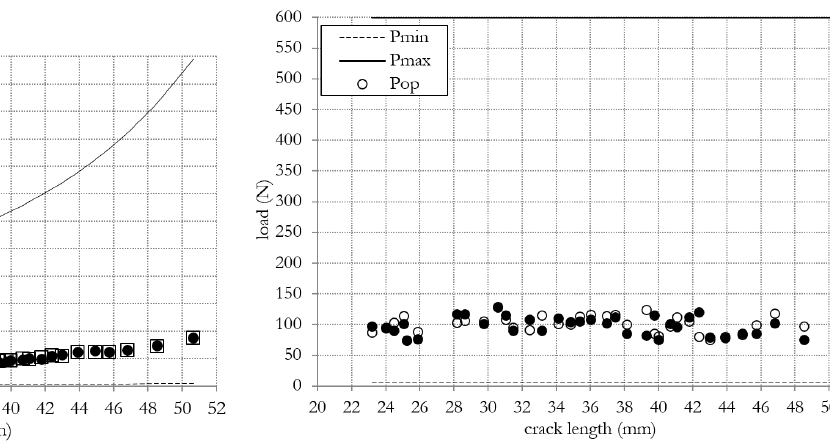
Figure 6: P op and P cl at different crack lengths for the specimen tested at low R -ratio.